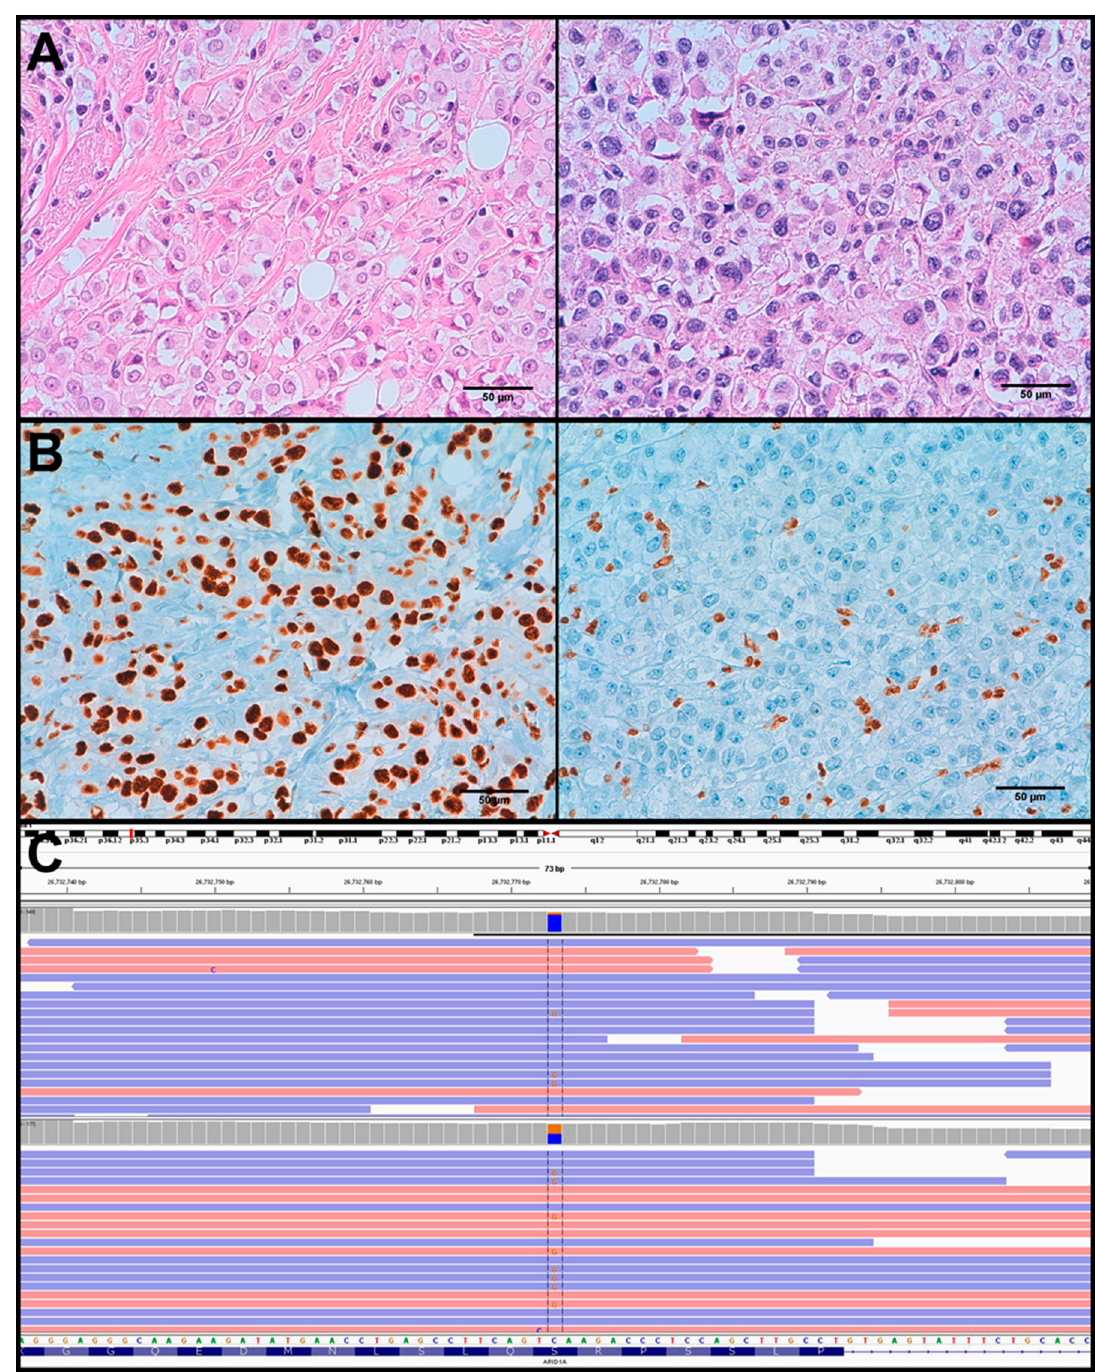
Figure 4. PLC24 sample. ( A ) H&E staining of invasive (left) and metastatic (right) components. ( B ) ARID1A positive staining of invasive component (left) and ARID1A negative staining of metastatic component (right). ( C ) IGV view of ARID1A S634* mutation frequency (orange) found by NGS sequencing in invasive (top, depth ~500) and metastatic (bottom, depth ~170) components.